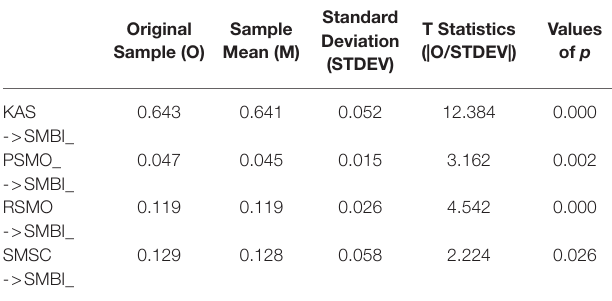
TABLE 4 | Result of structural model and hypotheses